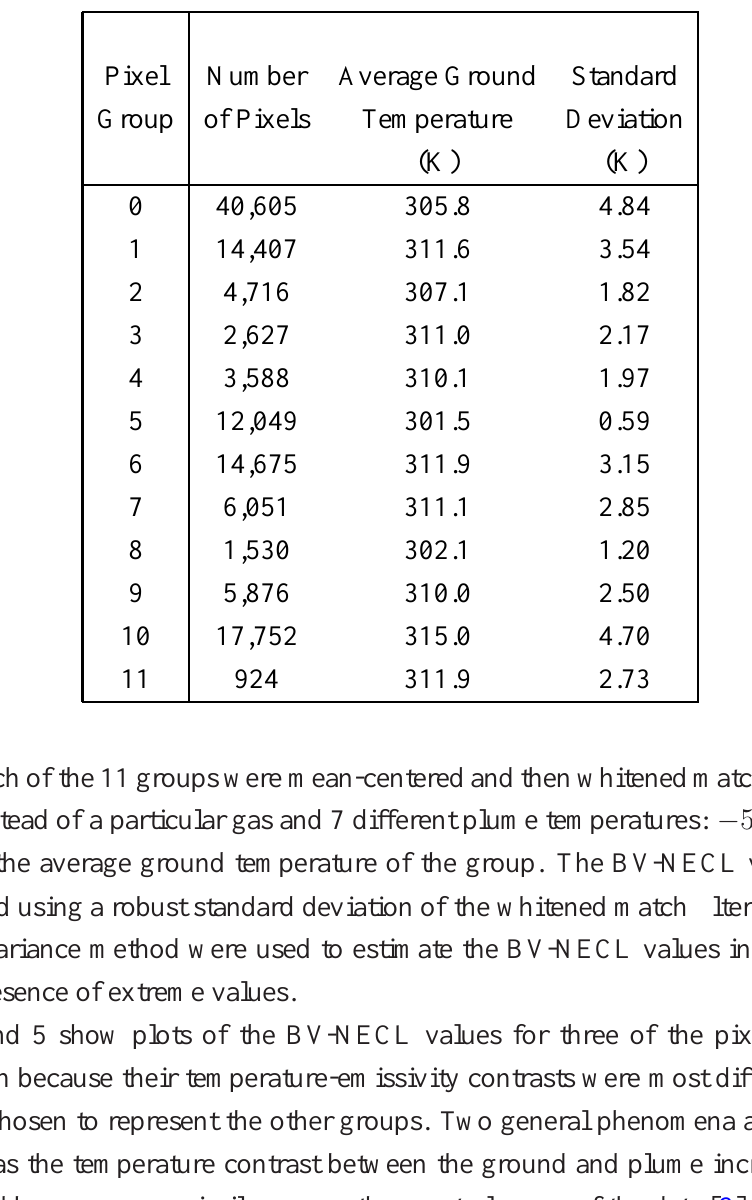
Table 1. Group segmentation